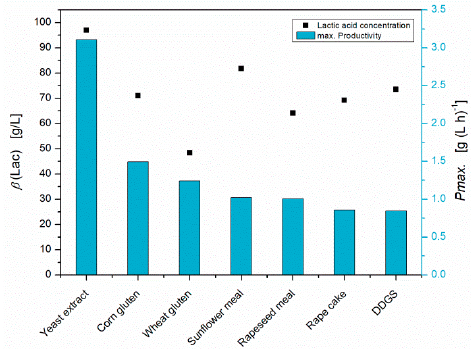
Figure 1. Lactic acid concentrations and maximal productivities of S. inulinus obtained with mildly hydrolysed agricultural residues as nutrient sources in GY-medium compared to the reference with yeast extract, incubated at 38 °C, 0 rpm.